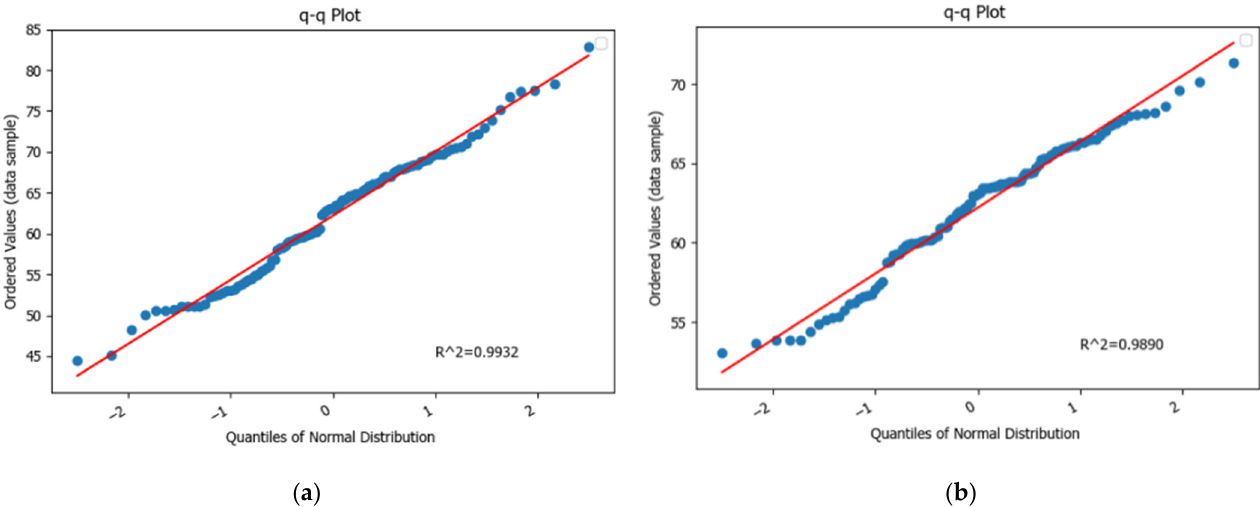
Figure 2. ( a ) Normality of observed noise level and ( b ) normality of predicted noise level.